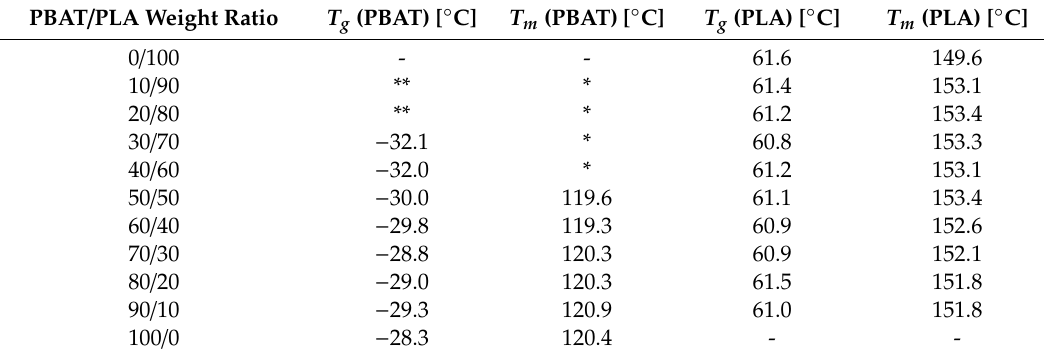
Table 4. Thermal characteristics from the second heating curves of pure PBAT, PLA and PBAT/PLA blends.